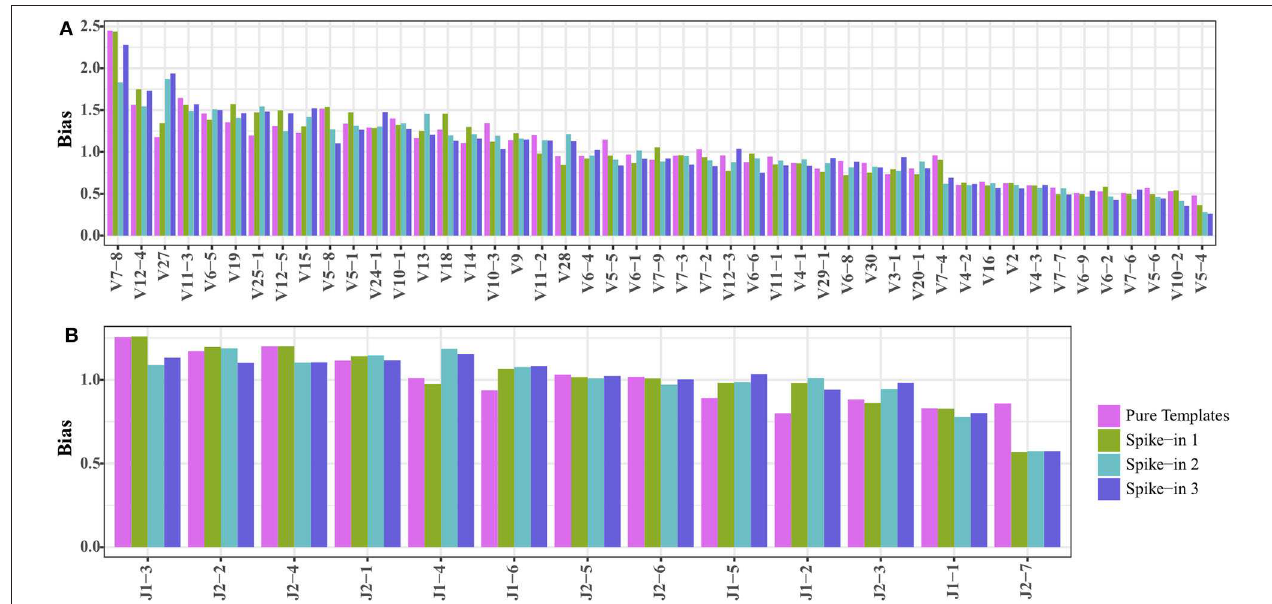
FIGURE 3 | Comparing the (A) TRBV and (B) TRBJ amplification bias of TRB templates as spike-in and pure templates. The spike-ins 1–3 indicated that 20,000 TRB templates were mixed with three natural DNA samples.